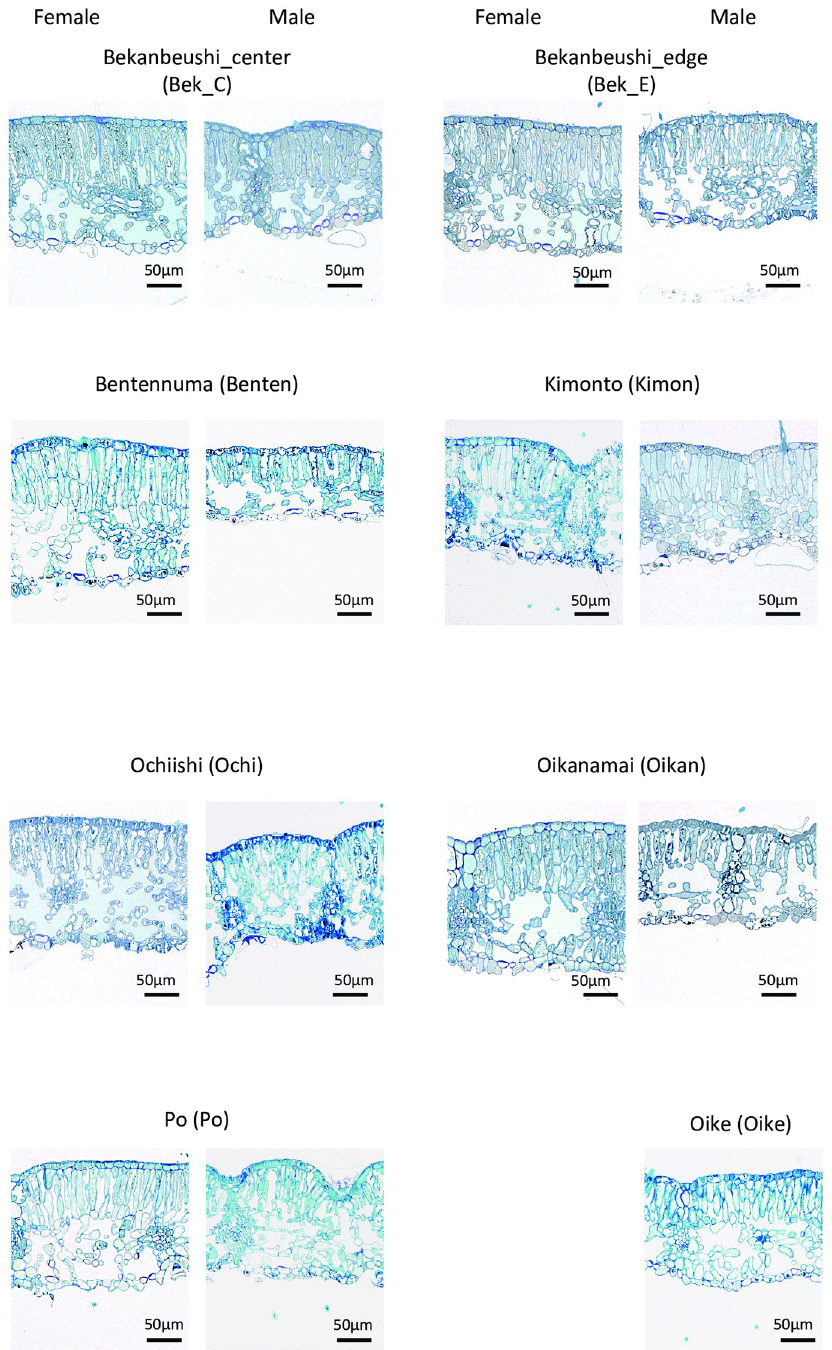
Fig 3. Transections of leaves of representative Myrica gale